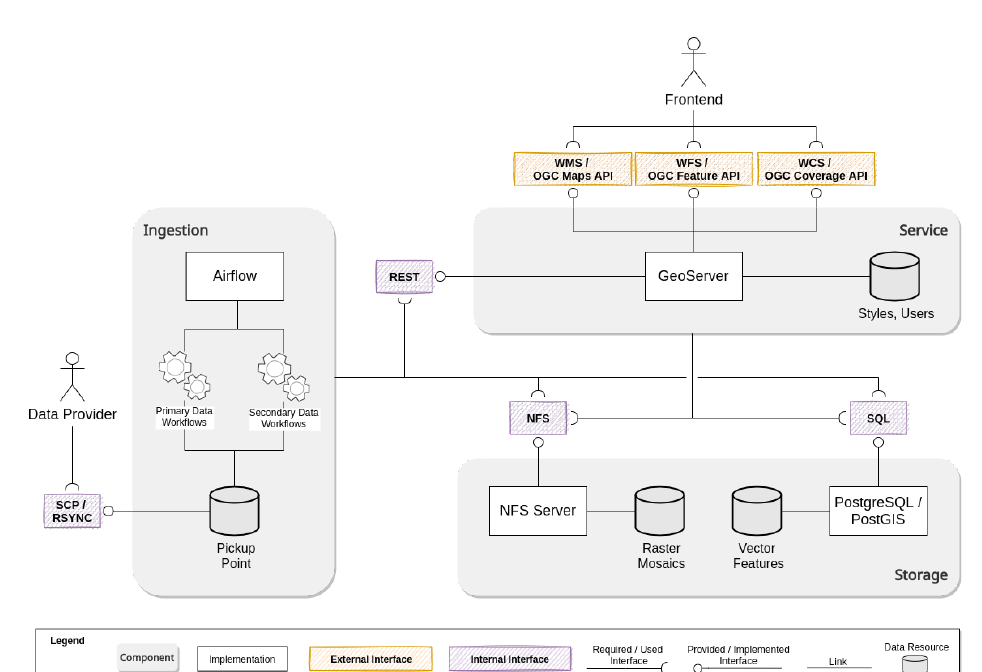
Figure 4. High-Level backend design depicting the components (grey boxes), implementations (white boxes), major data (grey cylinder), and public and internal interfaces (yellow, purple, respectively); simple lines denote link between elements; lines with half-open and circle ends represent used and provided interfaces,